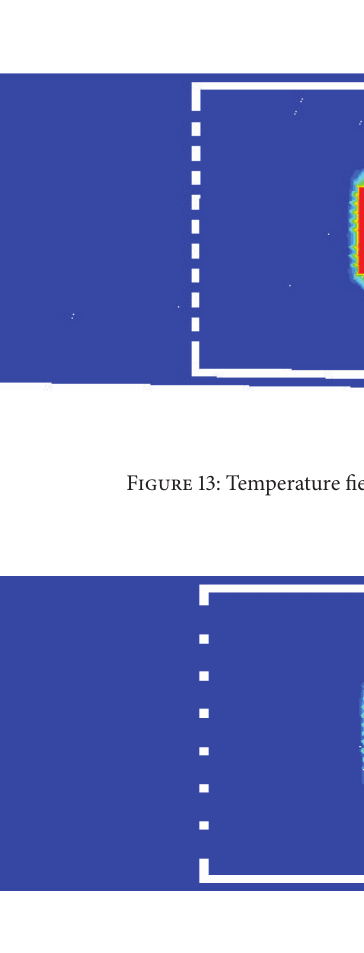
Figure 12: Temperature field distribution of the round hole in the section 𝑋 = 0 .